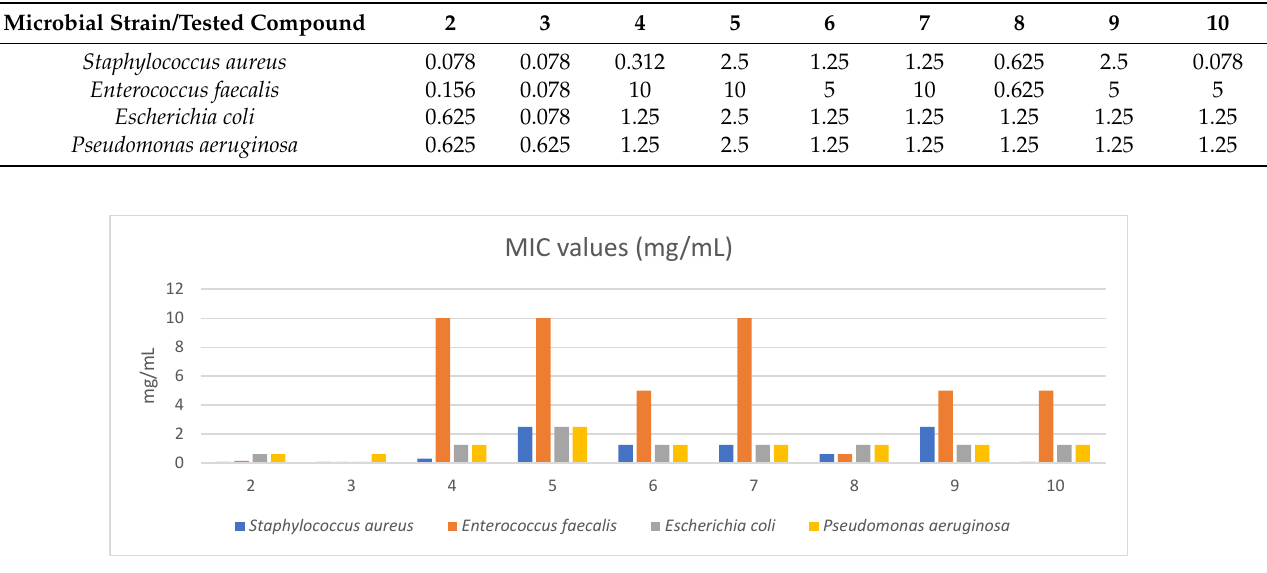
Table 3. The MBEC values (mg/mL) of the tested compounds.